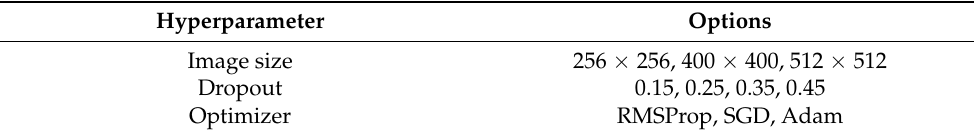
Table 3. Experimental hyperparameters evaluated for the proposed custom